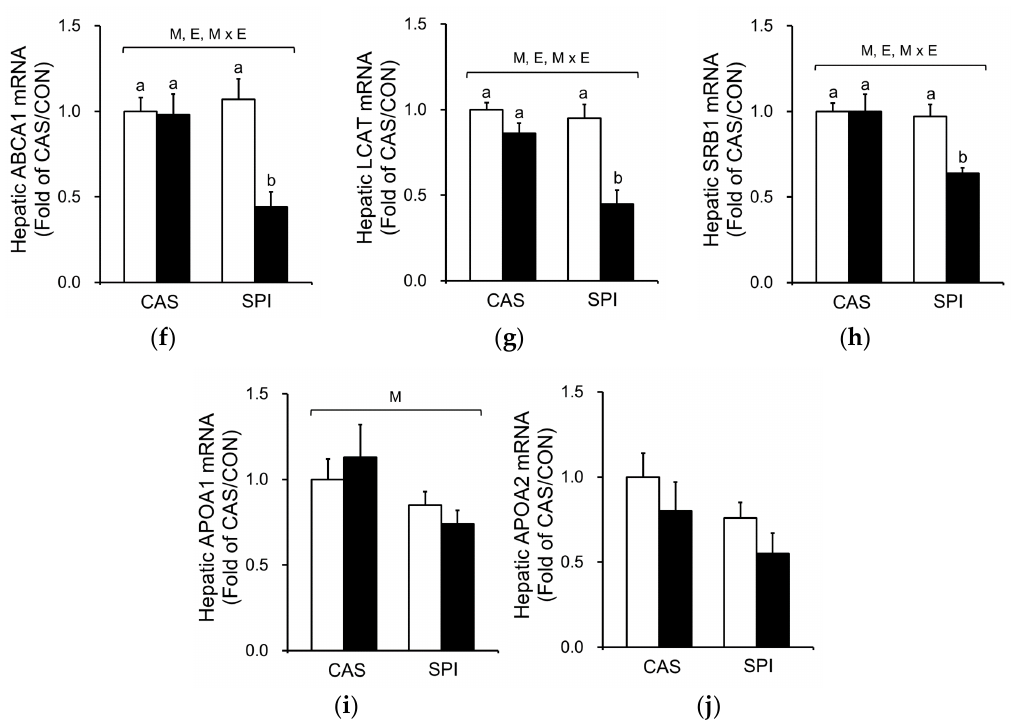
Figure 6. Effects of maternal diet on the gene expression related to cholesterol metabolism in the liver of adult offspring fed an ethanol diet. Hepatic mRNA levels of genes involved in ( a – e ) cholesterol metabolism and ( f – j ) HDL cholesterol metabolism ( n = 4–5). The mRNA levels were analyzed by real-time PCR and normalized to ACTB as an endogenous control. Data are expressed as means ± SEM. Significant effects of maternal diet (M), offspring ethanol diet (E), and their interaction (M × E) were analyzed by two-way ANOVA ( p < 0.05). Means without a common superscript significantly differ based on post-hoc analysis ( p < 0.05). Data that were not normally distributed were log-transformed before the statistical analysis. CAS, casein; SPI, low-isoflavone soy protein isolate; CON, control; EtOH, ethanol.